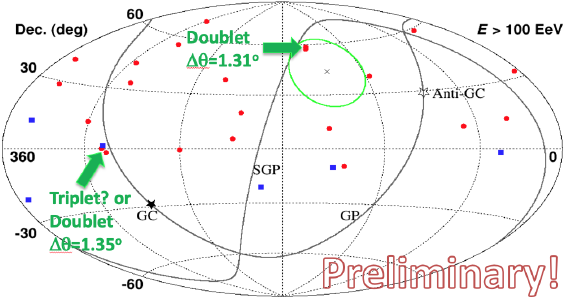
Figure 5. An Aito ff projection of the UHECR map in equatorial coordinates. The red circles and blue squares show directions of the UHECRs with E > 100 EeV observed by the TA and the PAO, respectively. The solid curves indicate the Galactic plane (GP) and the supergalactic plane (SGP). The closed and open stars indicate the Galactic center (GC) and the anti-Galactic cen- ter